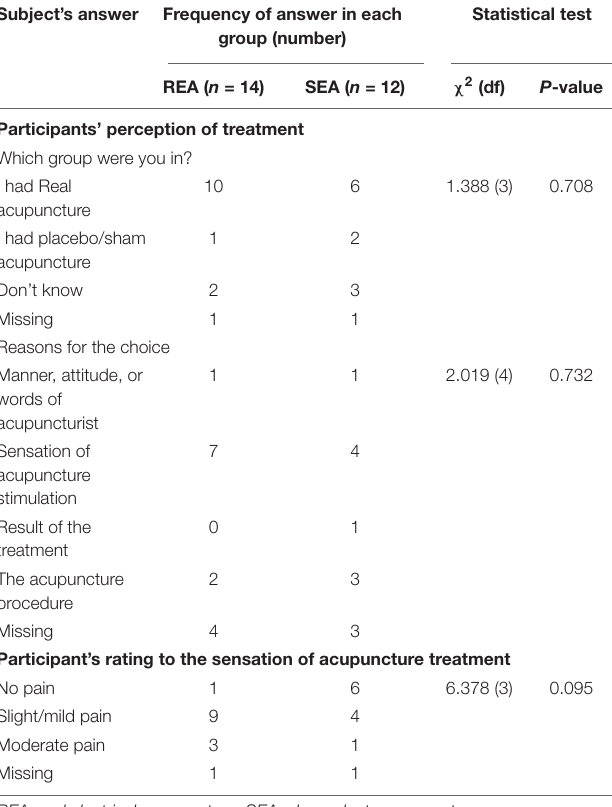
TABLE 2 | Participants’ perception of treatment and reasons for the